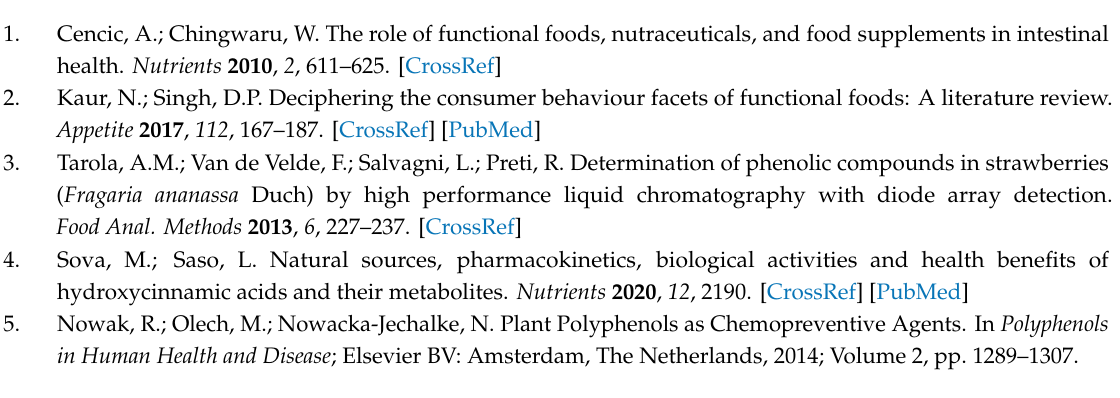
Supplementary Materials: Figure S1: Extracted LC-MS-MRM chromatogram of phenolic acids found in instant gruels with addition of 5% goji fruits; screw speed 100 rpm. MRM transitions are given in